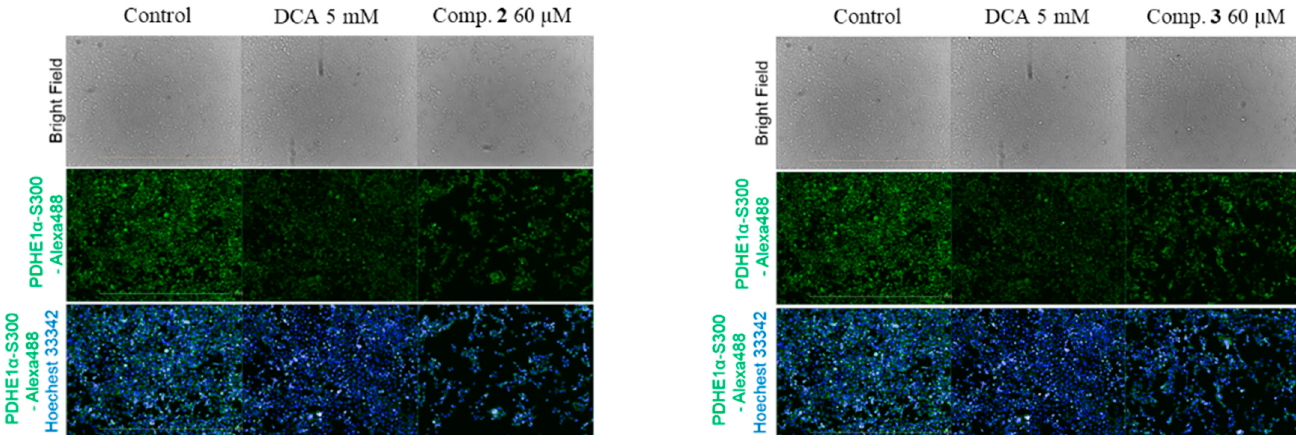
Figure 3. Fluorescent images of compounds 2 and 3 . Immunofluorescence analysis of p-PDH E1 α (Ser300) in AD-293 cells (green) treated with dichloroacetic acid (DCA) and compounds isolated from P. crocatum . The cell nuclei (blue) were stained with Hoechst 3334.